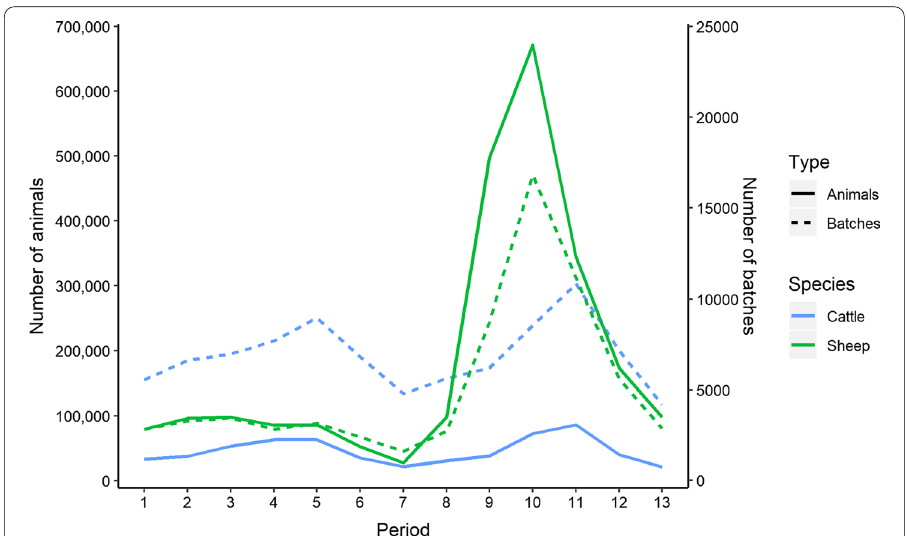
Fig. 1 Variation in volume of cattle and sheep movements. The graph shows the number of animals (axis on right), and the number of batches (axis on left) moved per species per 4‑week period of the year